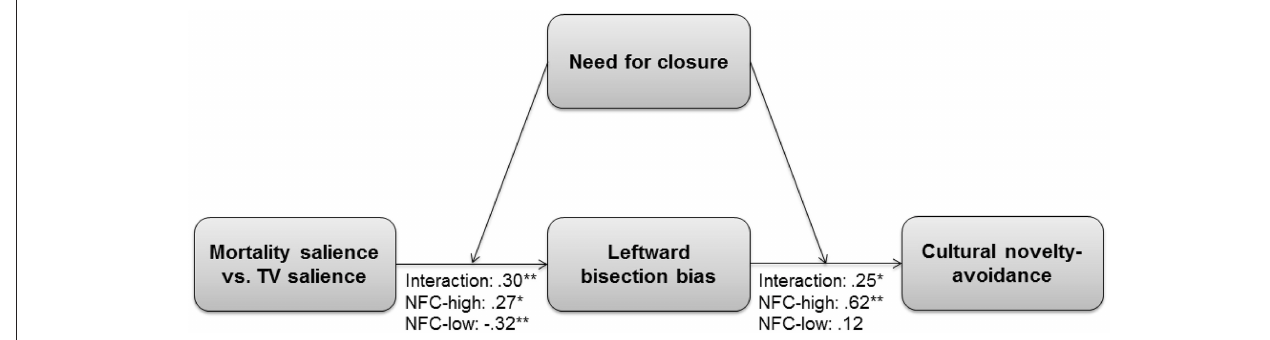
FIGURE 3 | Moderated mediation in Study 1. Mortality salience is coded as 1 and TV salience as 0. NFC-high = effects of the focal predictors (i.e., MS and leftward bias) under conditions of high need for closure ( SD = 1). NFC-low = effects of the focal predictors (i.e., MS and leftward bias) under conditions of low need for closure ( SD = − 1). Standardized regression coefficients ( β ) are indicated. *** p ≤ 0.001, ** p ≤ 0.01, * p ≤